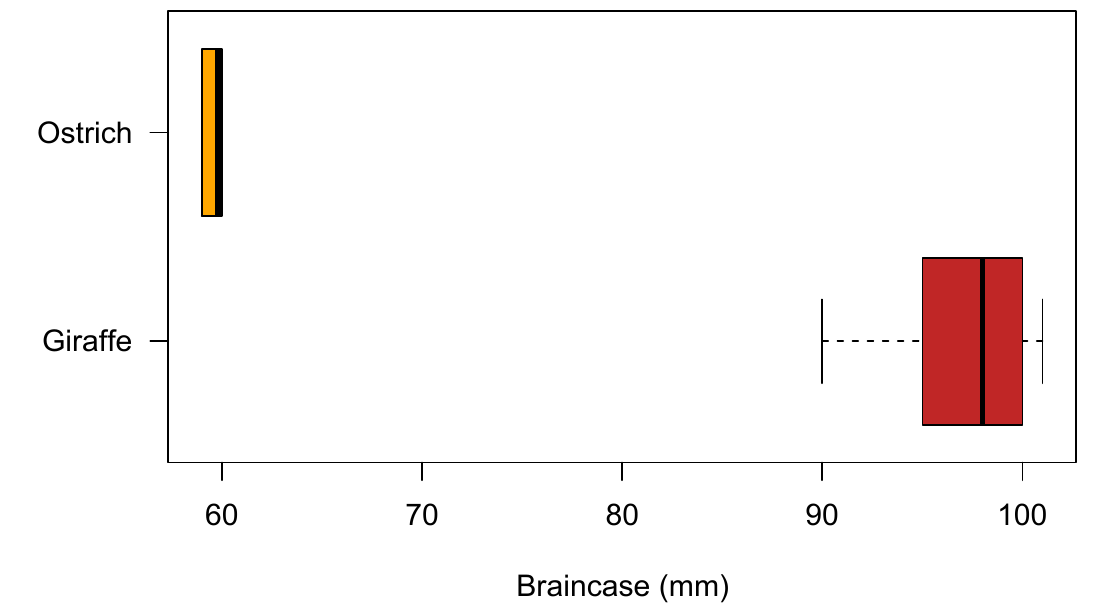
11 of 18 Figure 4. Diameter of the proximal ( A ) common carotid artery (CCA) with head lowered and distal ( B ) common carotid artery with head in the upright position. Diameter of proximal ( C ) internal jugular vein (IJV) and distal ( D ) internal jugular vein in an upright head position. Diameter of prox- imal ( E ) internal jugular vein (IJV) and distal ( F ) internal jugular vein in a head-lowered position. 3.2. Experiment Part 2: Braincase Measurements Skull samples were retrieved for giraffes (n = 5) and ostriches (n = 5) to measure the